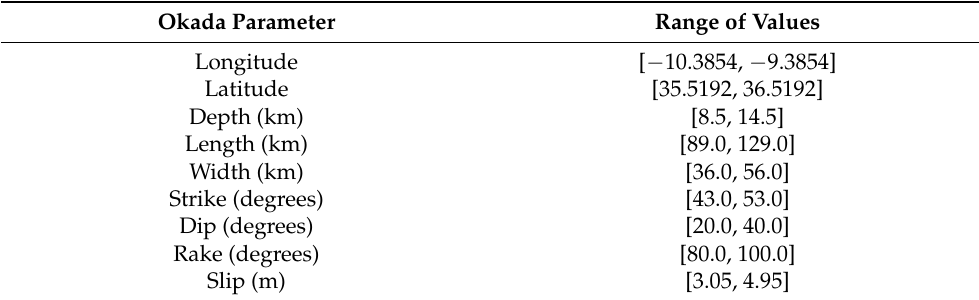
Table 1. Range of values for the Okada model parameters used for generating the numerical simula- tions used to train the NN